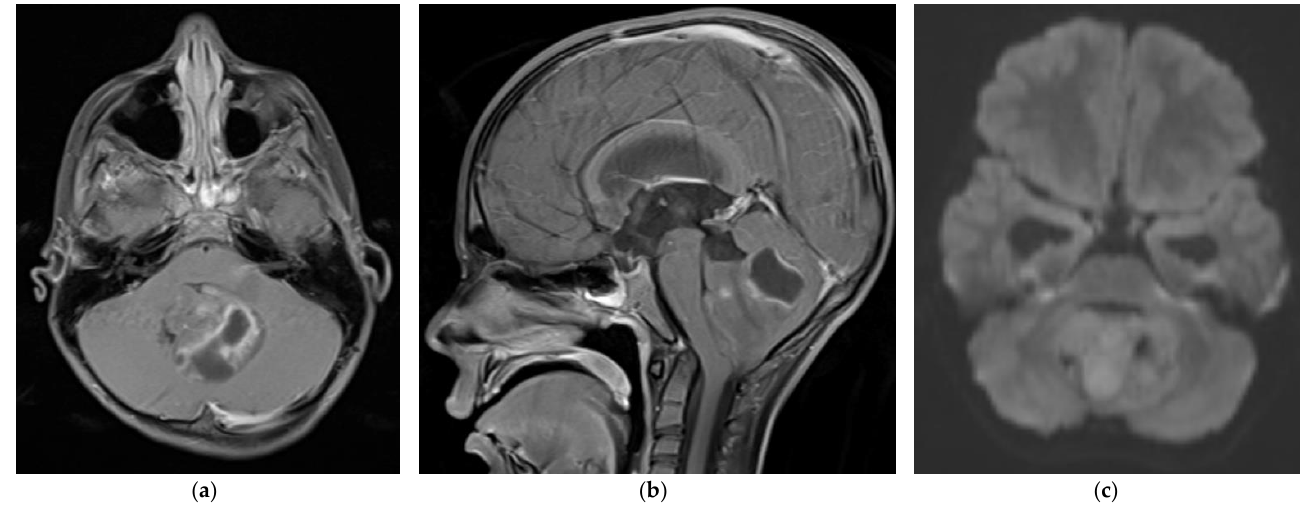
Figure 1. 5 year old boy with non-SHH/WNT medulloblastoma. Axial ( a ) and sagittal ( b ) T1- weighted MRI scans after intravenous contrast demonstrate a mass with cystic and solid components that enhances and extends into the fourth ventricle. The axial diffusion-weighted image (DWI) ( c ) shows restricted diffusion (higher signal intensity) within the tumor. The temporal horns of the lateral ventricles are distended, signifying obstructive hydrocephalus.